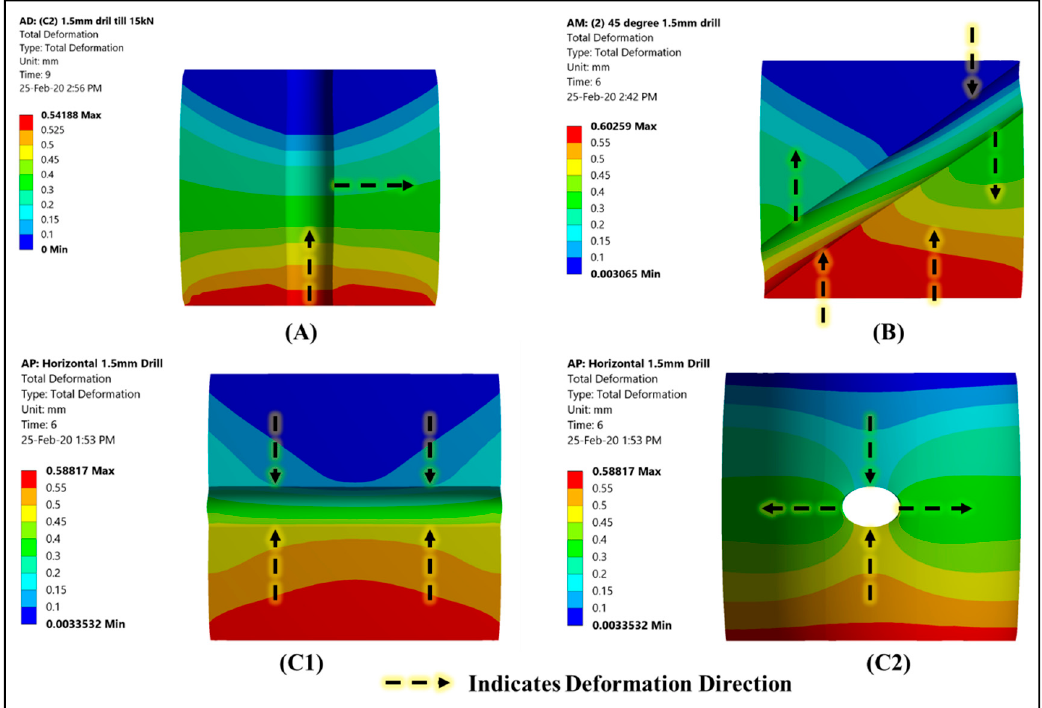
Figure 8. Deflection patterns for (A) vertical drill hole (B) angular drill hole and (C1, C2) horizontal drill hole orientations with the arrows indicating the deformation direction for each surface.